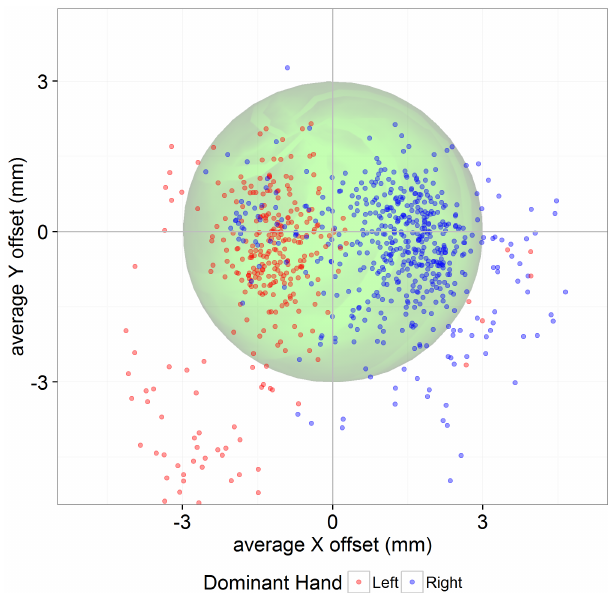
Figure 8. Session averaged touch bias (touch position deviation from target center) in mm (from 216 hits on average per session) by input hand left (red) and right (blue) from 798 sessions